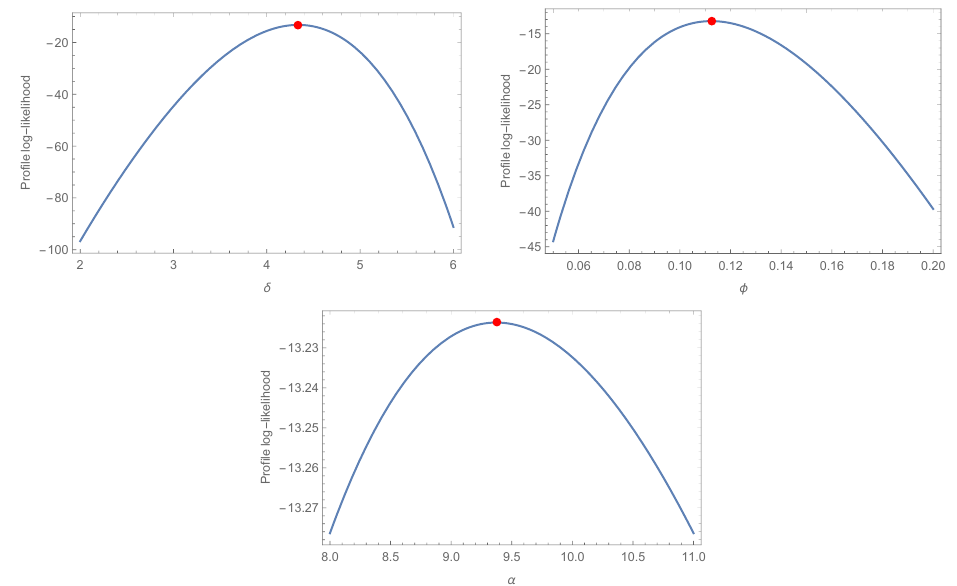
Figure 5. The profiles of the log-likelihood functions of ˆ δ MLE , ˆ φ MLE , and ˆ α MLE using the second engineering data